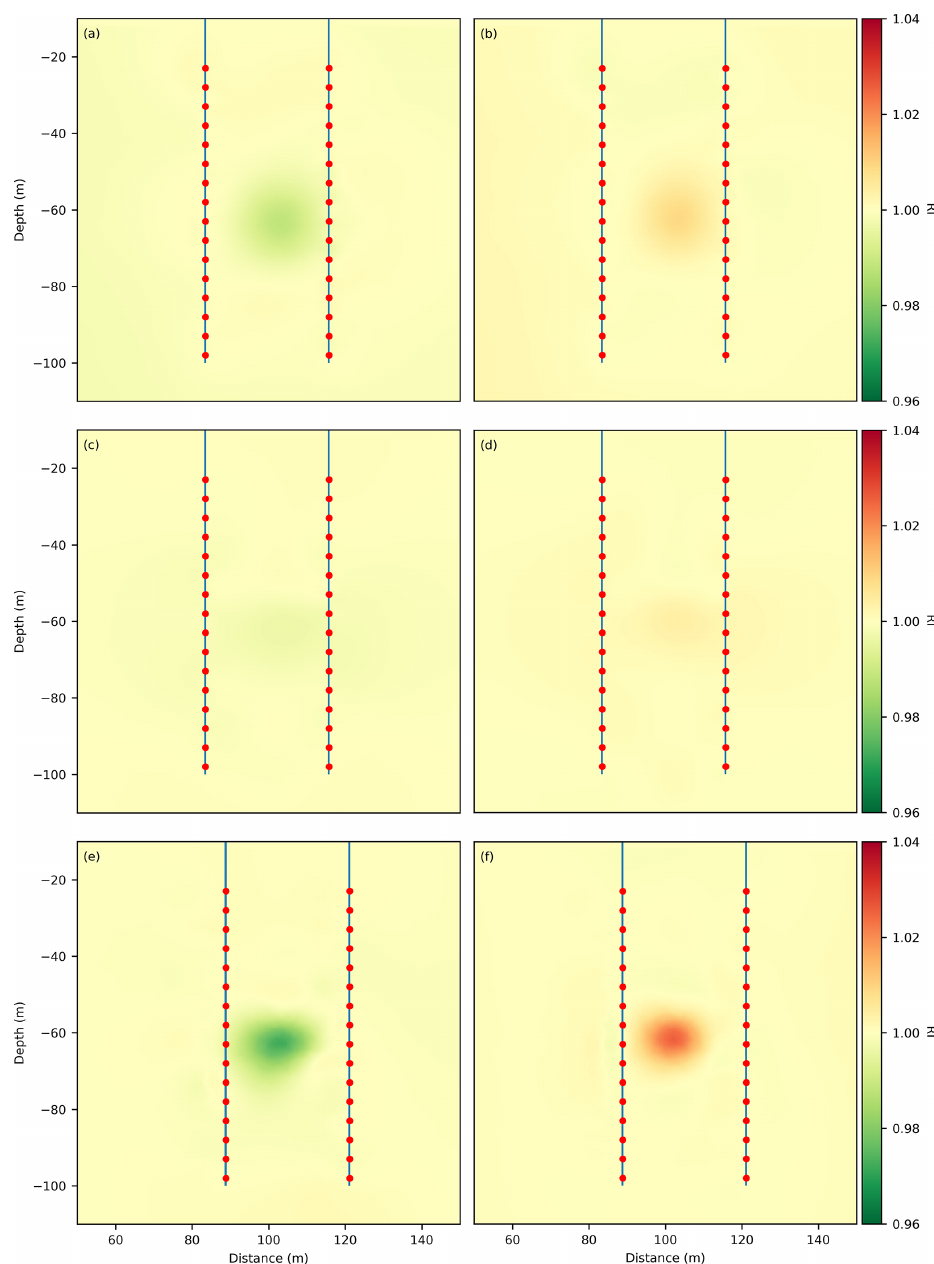
Figure 10. Inversion results in terms of the resistivity index R/R 0 for 1.7t of CO 2 injection. (a, b) Geometry optimized schedule AM–BN, (c, d) geometry optimized schedule AB–MN, (e, f) sensitivity optimized schedule. (a, c, e) CaCO 3 containing aquifer. (b, d, f) CaCO 3 free aquifer. The Chi 2 misfits for the inverion result containning the CO 2 plume are (a) 0.135, (b) 0.137, (c) 0.007, (d) 0.005, (e) 0.032, (f)